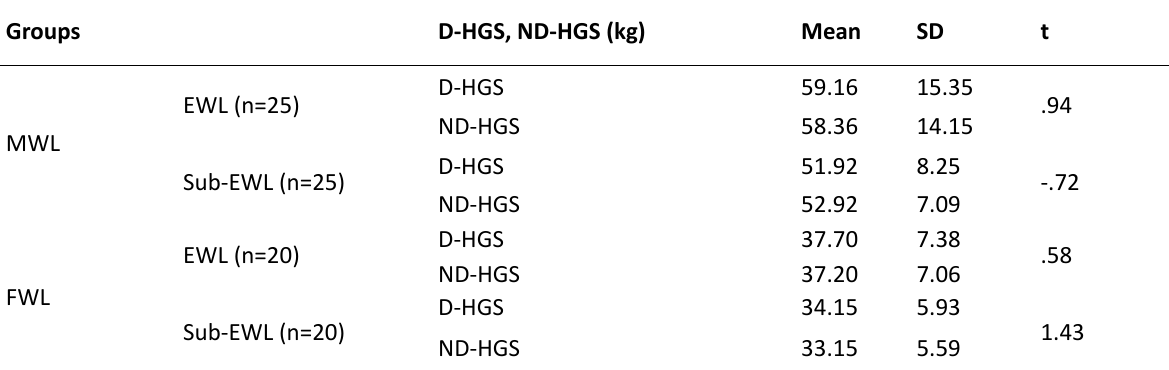
Table 3. The comparison of D-HGS and ND-HGS values of Olympic style weightlifting athletes. Groups